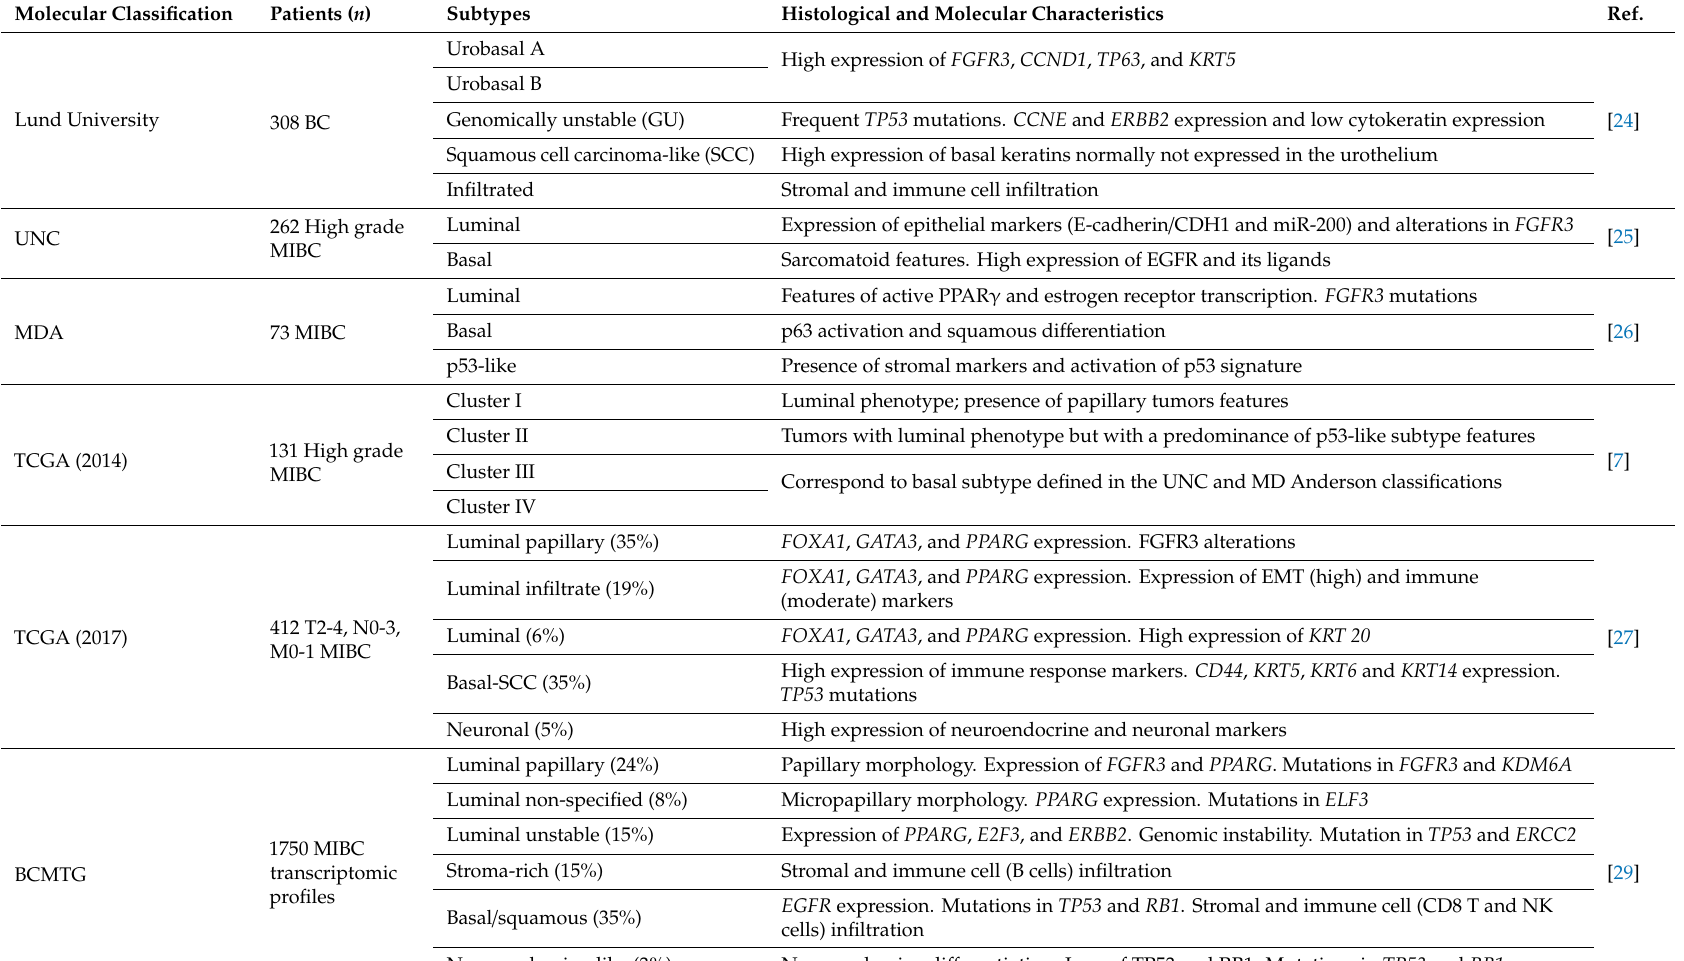
Table 1. Summary of the main characteristics of molecular subtypes of bladder cancer according to di ff erent molecular